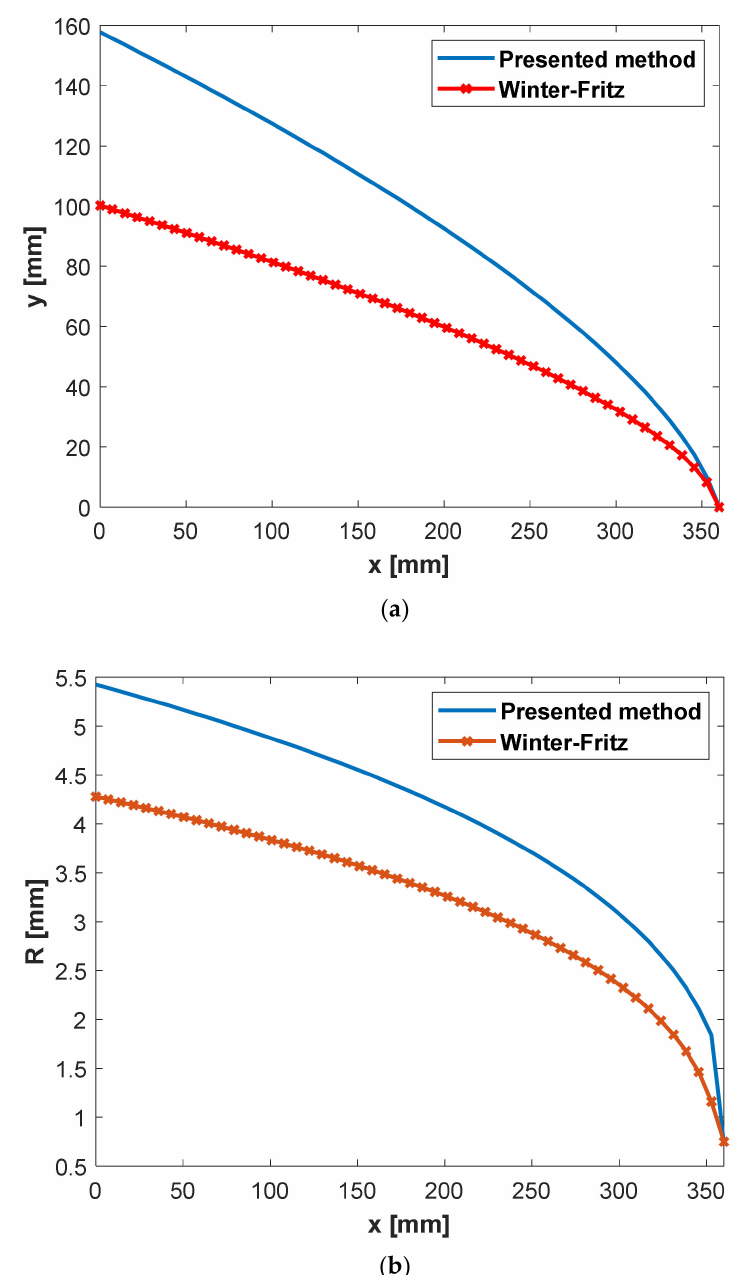
Figure 5. ( a ) Change of design parameter y with respect to x ( b ) Change of manifold radius R with respect to x for power-law polypropylene (parameters in Table 2) with a circular